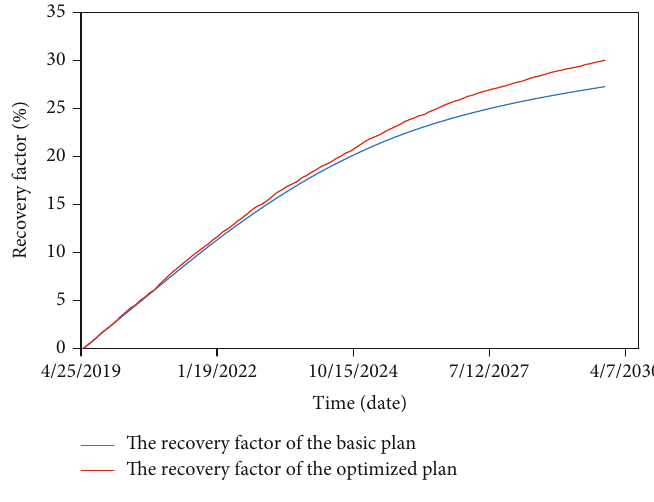
Figure 15: Comparison of recovery